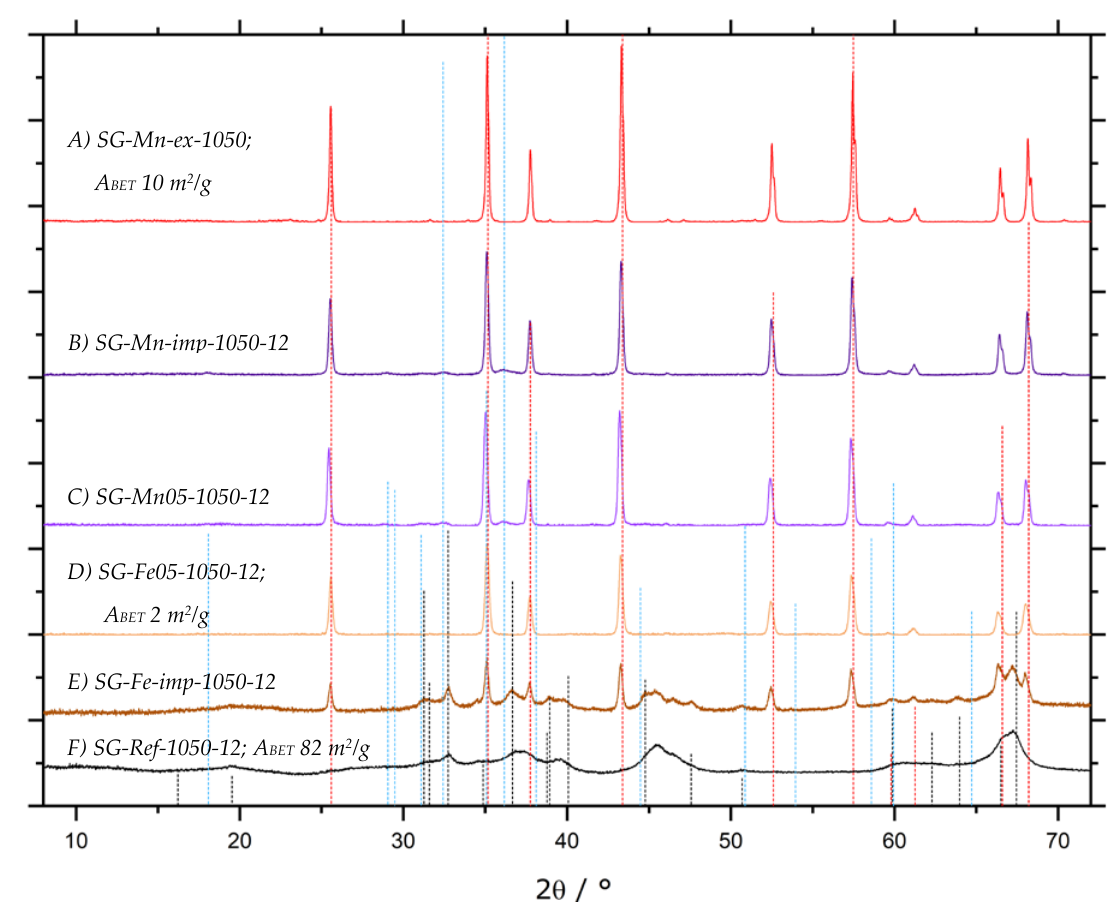
Figure 16. XRD patterns of sol-gel samples calcined at 1050 °C for 12 h. The undoped reference sample SG-Ref0-1050-12 ( F ) shows a pattern of poorly crystallized θ -Al 2 O 3 . Impregnation with ferreous precursor solution ( E ) has a much weaker effect than the one observed for Mn ( B ), which contains only α -Al 2 O 3 and hausmannite Mn 3 O 4 . Much of the hausmannite can be dissolved by acid leaching, giving an XRD-pure α -Al 2 O 3 pattern ( A ). Sample SG-Mn05-1050-12 ( C ), synthesized from 95 mol-% Al- and 5 mol-% Mn-precursors, gives a similar pattern to the impregnated sampe ( B ), while incorporation of hexagonal α -Fe 2 O 3 from ferreous precursors enables a facilitated α -transition ( D , sample SG-Fe05-1050-12), with no detectable ferreous crystal phases. Red dotted lines indicate α -Al 2 O 3 reflexes, black dotted lines indicate θ -Al 2 O 3 reflexes. Hausmannite reflexes are marked in blue.